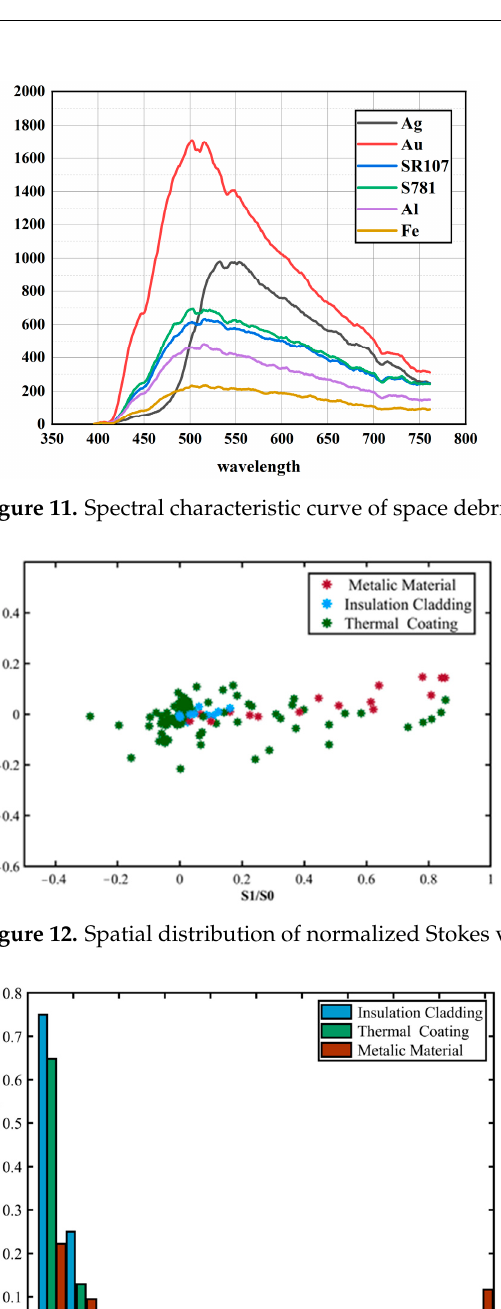
13 of 17 Figure 10. Image after edge processing. Table 3. Analysis of various materials cluster results. Material